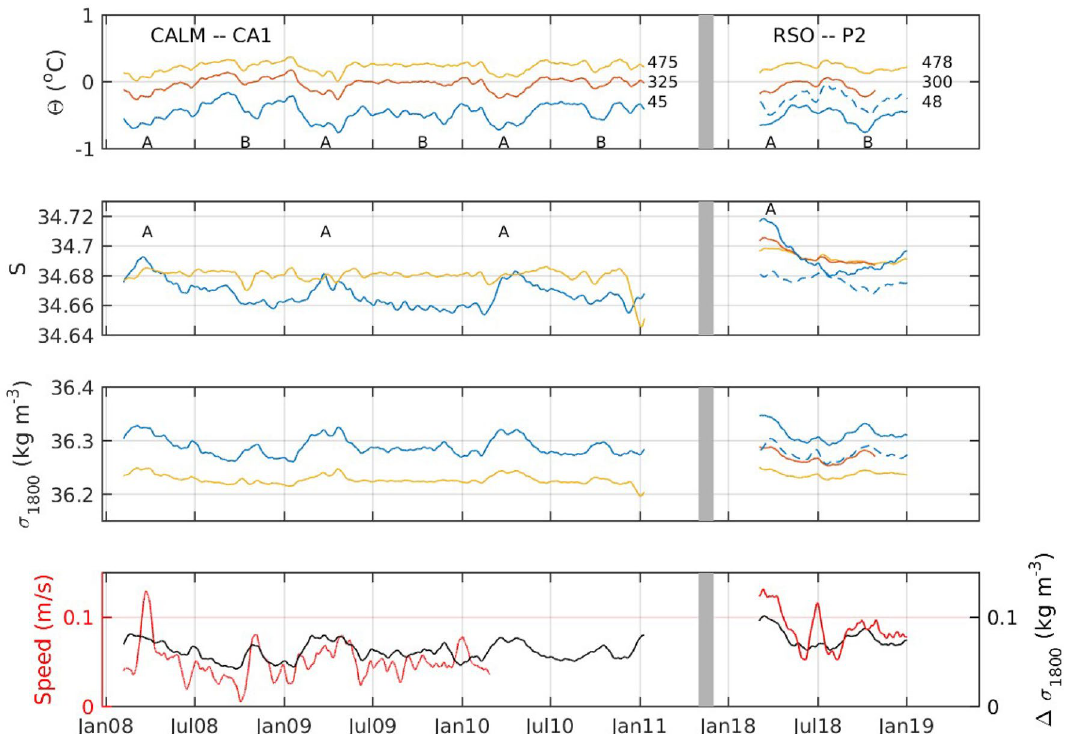
Figure 2. The potential temperature (top panel), salinity (second panel) and potential density at 1800 m (third panel) at the location of the CALM CA-1 mooring and the RSO-P2 mooring. The grey line indicates a discontinuity in time. Sensor height above bottom is shown next to the time series in the upper panel. The letter ’A’ marks the cold, salty period every year between March and May. The letter ’B’ marks the second cold period during October. The bottom panel shows the density difference between ~ 45 and ~ 475 m above bottom (black line) and the speed of the current at ~ 475 m above bottom (red line). The dashed blue lines show the water properties at the bottom sensor (48 m above bottom) at the RSO P3 mooring on a similar isobath near the Drygalski